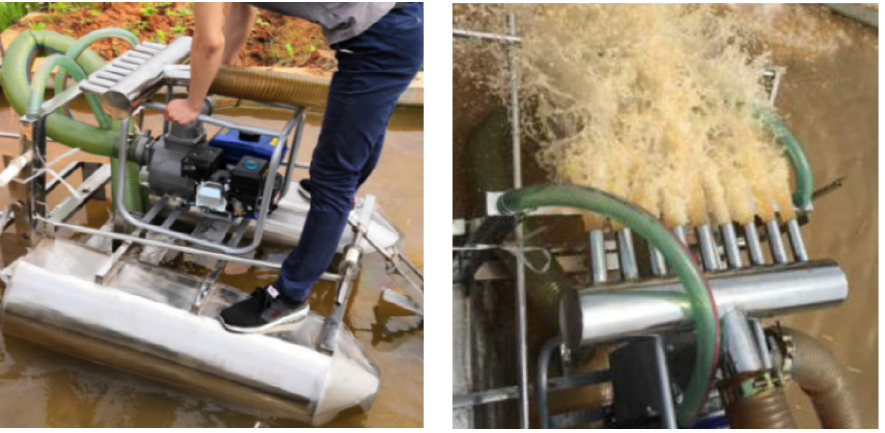
Figure 6. Buoyancy pool test.